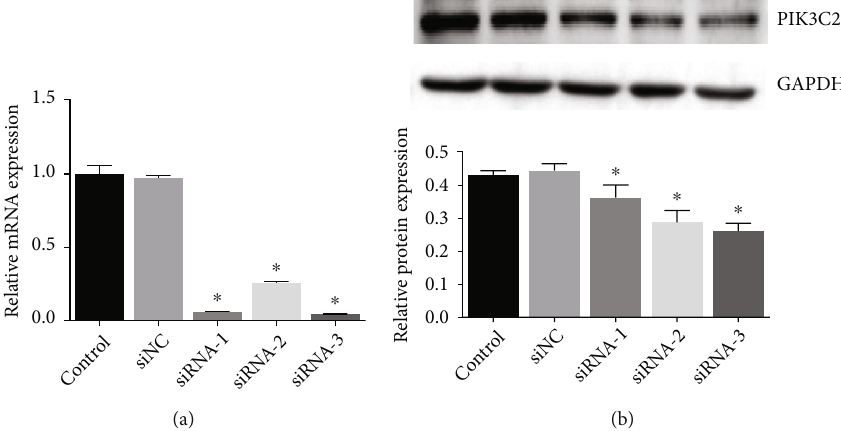
Figure 6: PIK3C2A knockdown in angiotensin II-treated aortic VSMCs. PIK3C2A was knocked down using three independent siRNAs in angiotensin II-treated aortic VSMCs, and knockdown was con fi rmed at both mRNA level by RT-qPCR (a) and protein level by Western blot (b). Experiments done in triplicate. ∗ P < 0 : 05 vs.